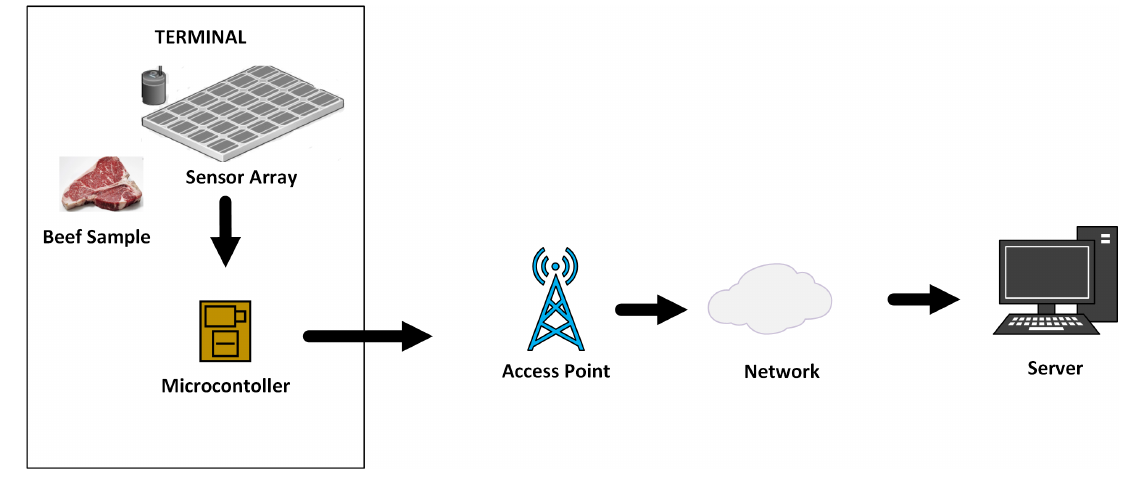
Figure 1. A conceptual food quality